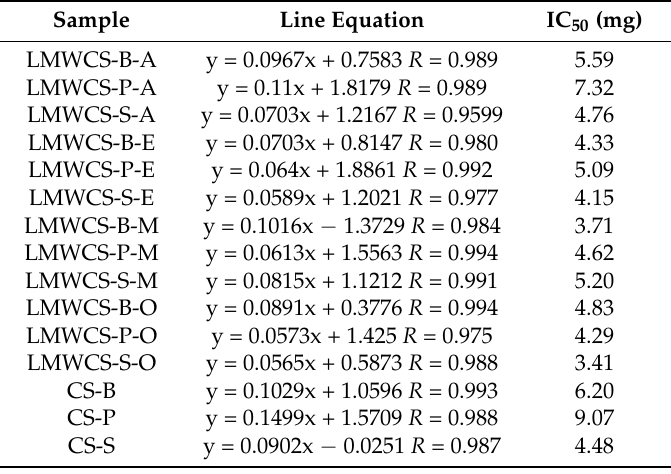
Table 2. Anti-complement capacity of chondroitin sulfates (CSs) from three sources and the depolymerized derivatives.